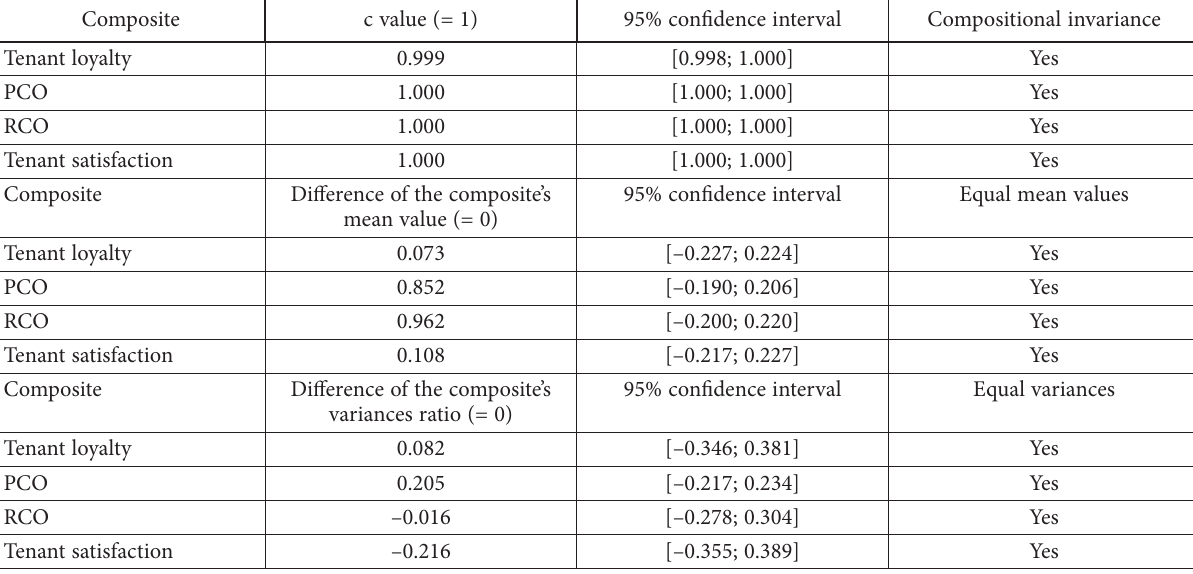
Table 4. Measurement invariance test using